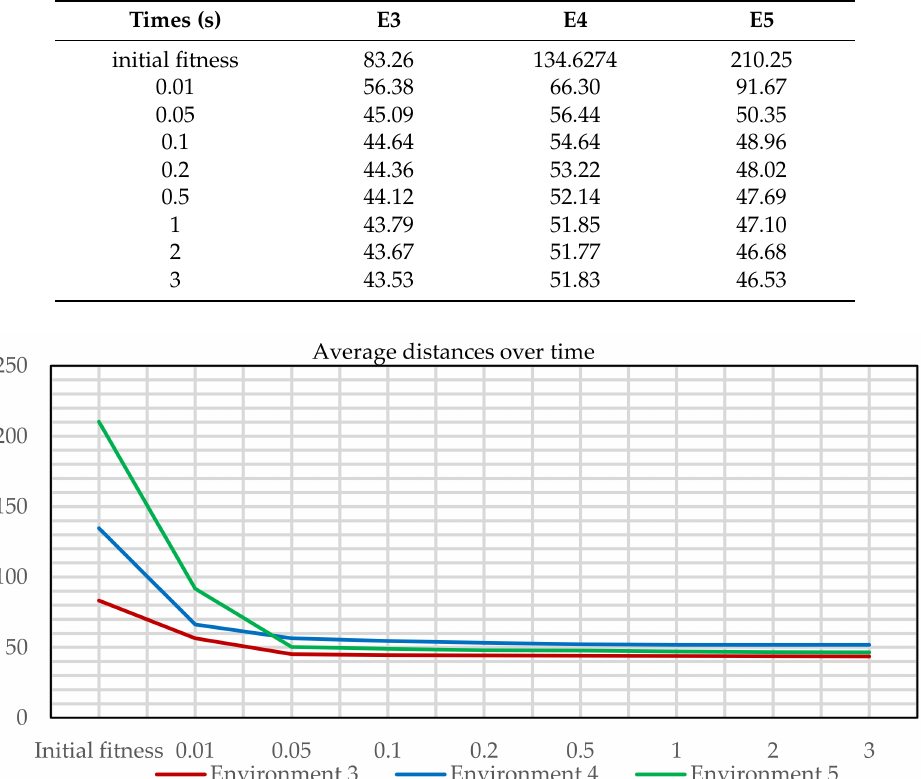
Table 6. Average distances over time in Environments 3, 4, and 5.